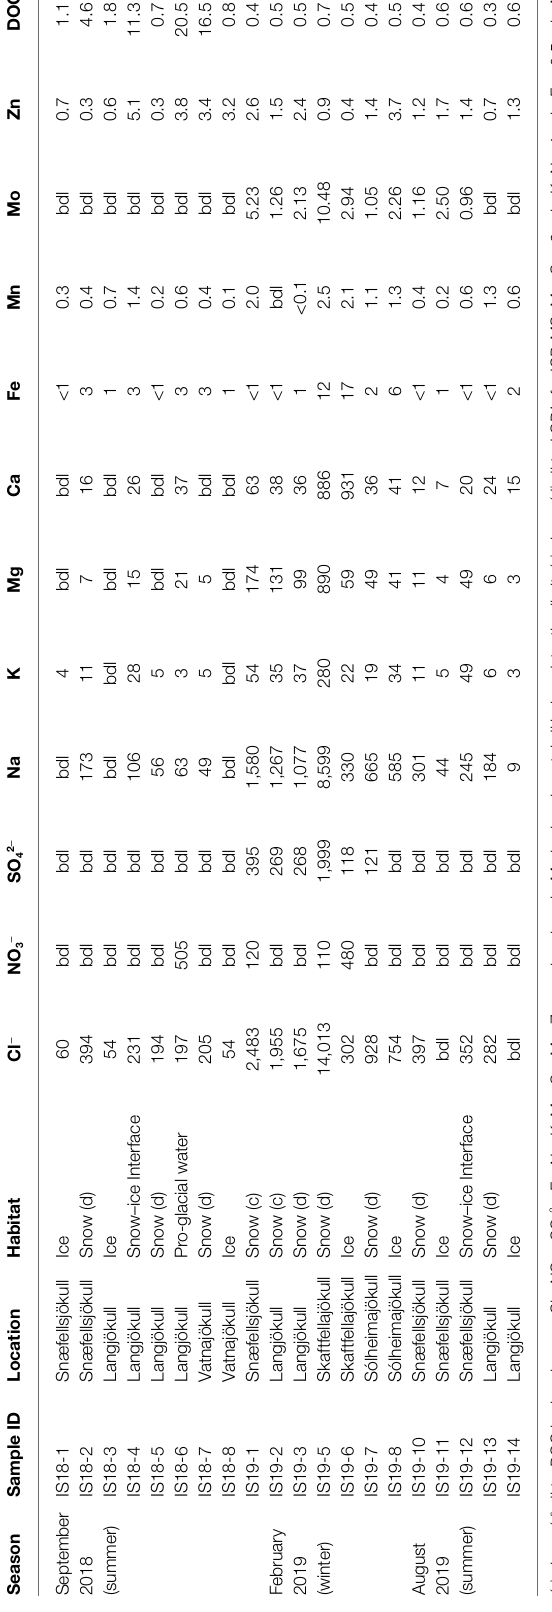
snow algae of the genus Hydrurus , commonly found in “yellow snow” (Remias et al., 2013). The Plantae consisted of the two phyla Chlorophyta (13%–65%) and Phragmoplastophyta (<1%–15%; Figure 3 ). The Chlorophyta include the typical snow algae of the genera Chloromonas , Chlainomonas , and Sanguina , which cause the often observed red and green snow blooms (Lutz et al., 2016; Remias et al., 2016; Engstrom et al., 2020). The dominant glacier ice algae in our samples were Phragmoplastophyta , which include the well-known glacier ice algae of the genera Mesotaenium and Ancylonema (Remias et al., 2009, 2012). We extracted algal ASVs and clustered them using Bray– Curtis dissimilarities, revealing that samples were mainly clustering according to differences in habitat—with the exception of the snow–ice interface sample IS19-12 ( Figure 4A ) and ice samples from Snæfellsjökull (IS18-1 and IS19-11). In sample IS19-12, more than 90% of the reads belonged to the genus Chlainomonas ( Figure 4B ), with its typical red xanthophyll rich pigmentation that causes the dark red color of this sample ( Figure 4D ). One cluster (IS18-6, IS19-14, IS18-3, IS18-8), which contained only ice samples and the pro-glacial water sample, had high numbers of the genera Mesotaenium and Ancylonema ( Figure 4B ). Summer ice samples from Snæfellsjökull (IS18-1 and IS19-11) contained negligible proportions of glacier ice algae and clustered with snow from the other summer samples ( Figure 4A ). Chloromonas and Hydrurus and the permafrost/soil algae Raphidonema were dominant in all snow samples and in the snow–ice interface sample IS18-4 ( Figure 4B ). Beta diversity analysis via NMDS of all samples showed a separation between snow and ice samples, with snow–ice interface samples (IS18-4 and IS19-12) plotting in between. The pro-glacial water sample clustered with the ice samples ( Figure 4C ). In all summer samples, sequencing of the ITS2 gene showed a dominance of Chloromonas across all habitats and locations, with the exception of the snow–ice interface sample IS19-12, which was dominated by Chlainomonas ( Supplementary Figure S3B ). This result mirrors our 18S rRNA gene data ( Figure 4 ), but the sequencing of the ITS2 gene missed the glacier ice algae of the phylum Phragmoplastophyta that were present in our 18S rRNA data ( Figure 4 vs. Supplementary Figure S3A ). Contradictory to the 18S rRNA gene sequences ( Figure 4 ), we found that in the ITS our samples were dominated by Koliellaceae / Pseudochlorella ( Supplementary Figure S3B ), but other dominant taxa such as Hydrurus , seen in the 18S rRNA data, were missing ( Figure 4B ). Bacterial Communities Bacterial 16S rRNA genes were amplified and sequenced in all winter and summer samples and across all habitats. DNA concentrations were low or below Qubit detection levels (<0.01 μ g ml − 1 ) in all winter samples. Sequences were clustered using Bray–Curtis dissimilarities. We found that summer and winter bacterial communities were distinct from each other ( Figure 5A ). Bacterial communities in summer (2018 and 2019) were very similar to each other, only partially clustering by habitat type, while they clearly differed from winter communities ( Figure 5 ). T A